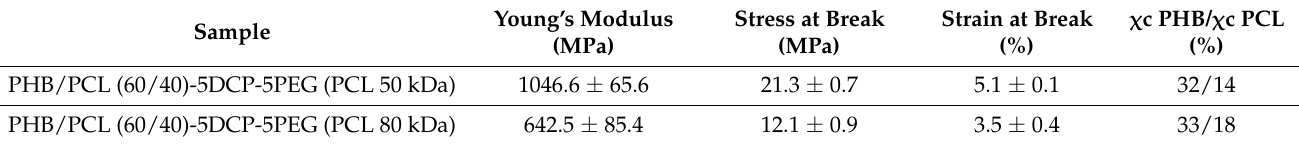
Figure 9. PHB/PCL-based materials FDM 3D printing: − 45 ◦ /45 ◦ filament deposition during the printing process of impact test samples ( A ). Sample images before and after impact tests of blend containing PCL (80 kDa) ( B ), and stress–strain curves of the printed materials ( C ). FDM 3D printed prototype presenting prosthetic finger with different degrees of freedom ( D ). Specimens presented in images ( A , B ) present same size 63.5 × 12.7 × 3.2 mm 3 (ASTM D256, standard). Table 6. Printed samples tensile test results.